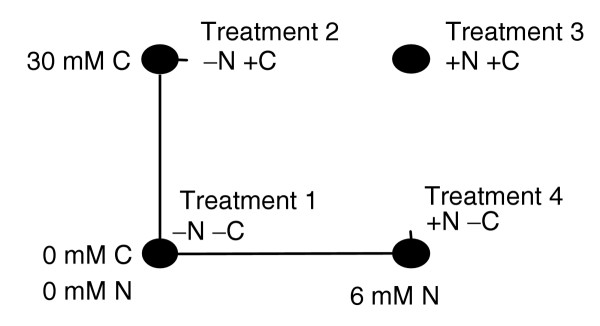
Treatments for carbon and nitrogen interaction studies. +C, -C, with and without carbon, respectively. +N, -N, with and without nitrogen, respectively.